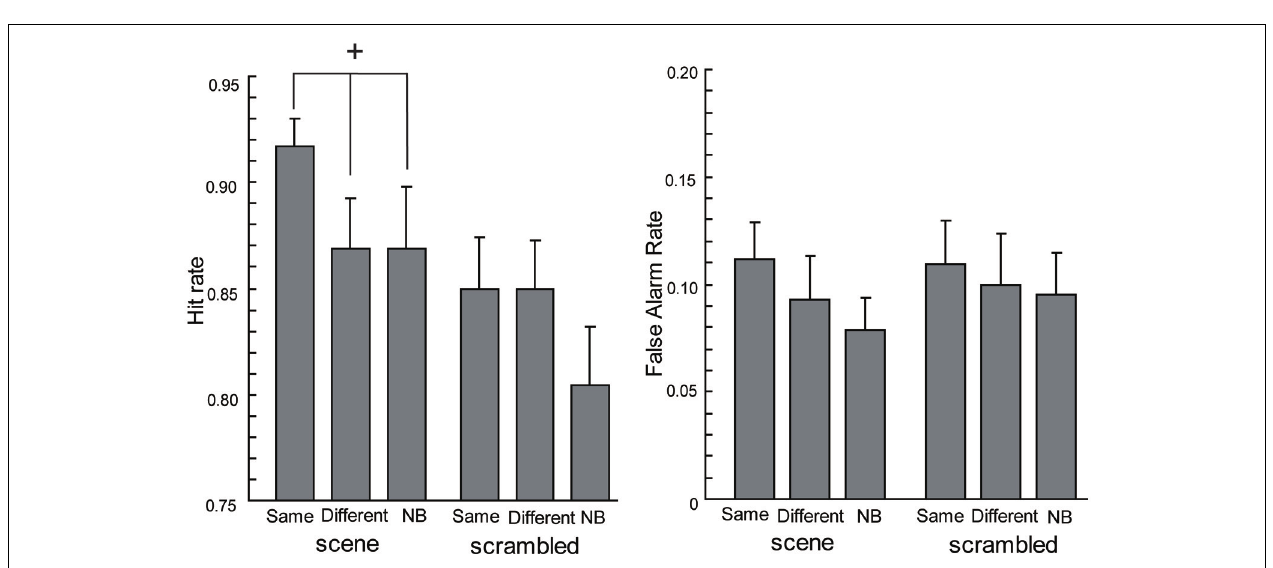
FIGURE 2 |The hit rates and false alarm rates of the current experiment. Error bars are standard errors of means.The cross means a significant tendency ( p < 0.1).